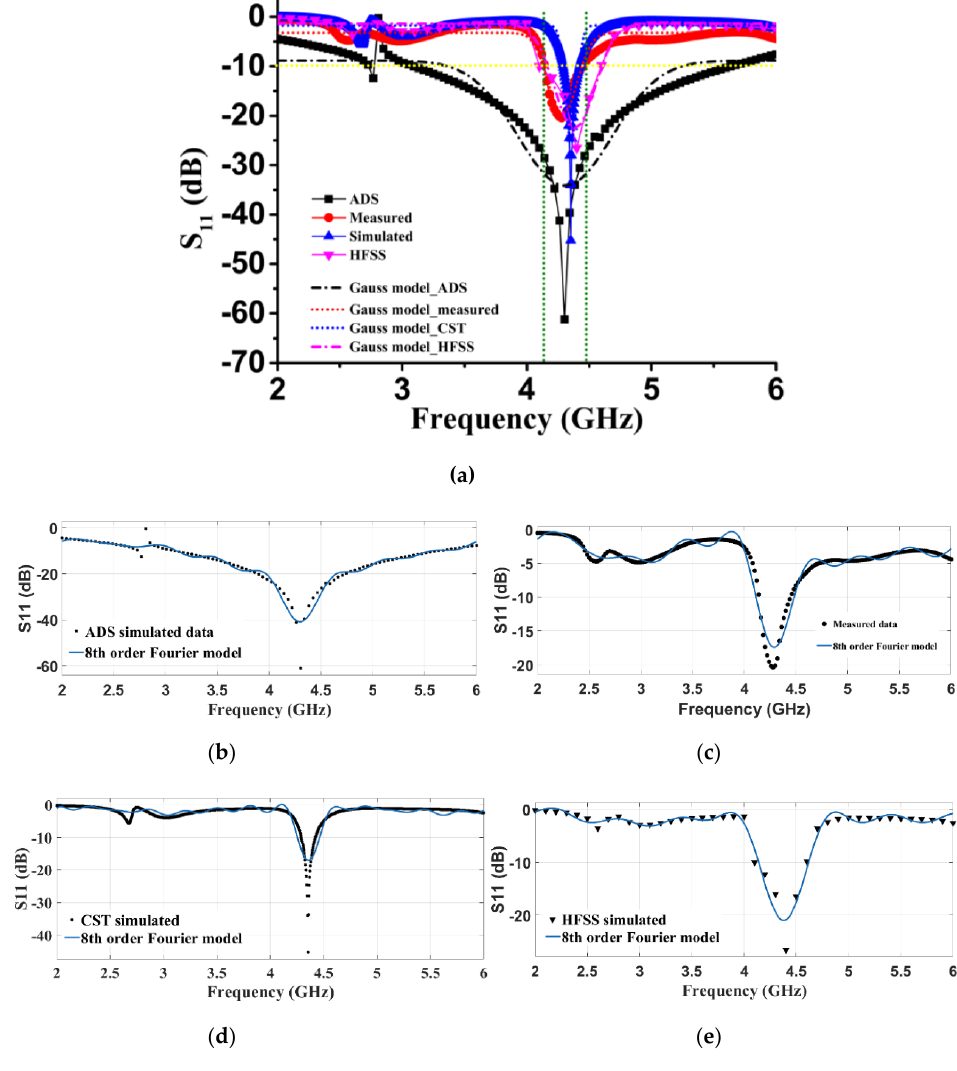
Figure 9. S 11 Response and data analysis using curve fitting ( a ) Gaussian model; Fourier transform method for ( b ) ADS; ( c ) Measured; ( d ) CST simulated; and ( e ) HFSS simulated.